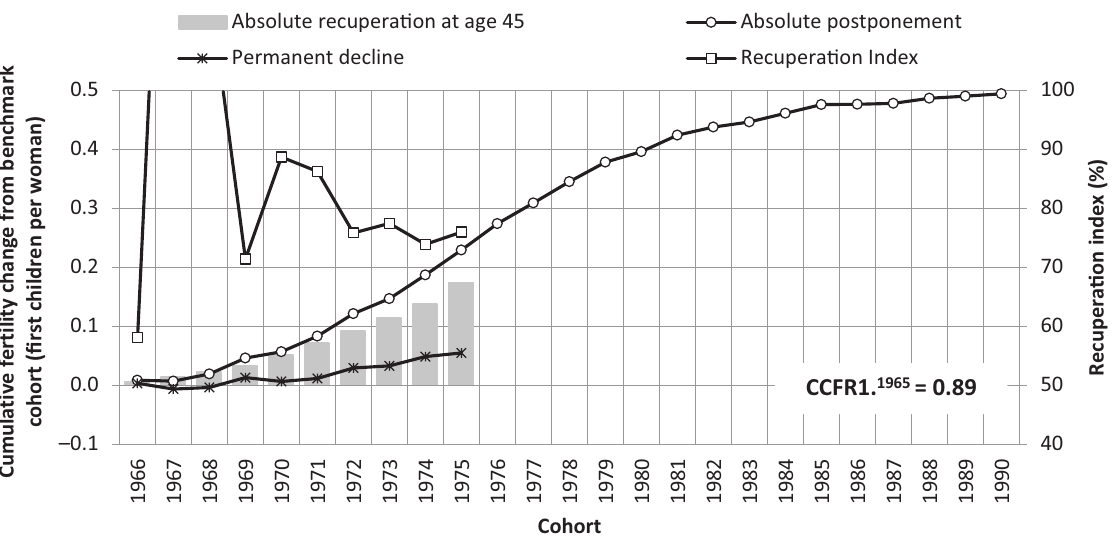
Figure 2. The postponement and recuperation of first births in Slovakia: 1966–1990 cohorts. Source: Author’s calculations based on Statistical Office of the Slovak Republic (1992–2020, 2021a).